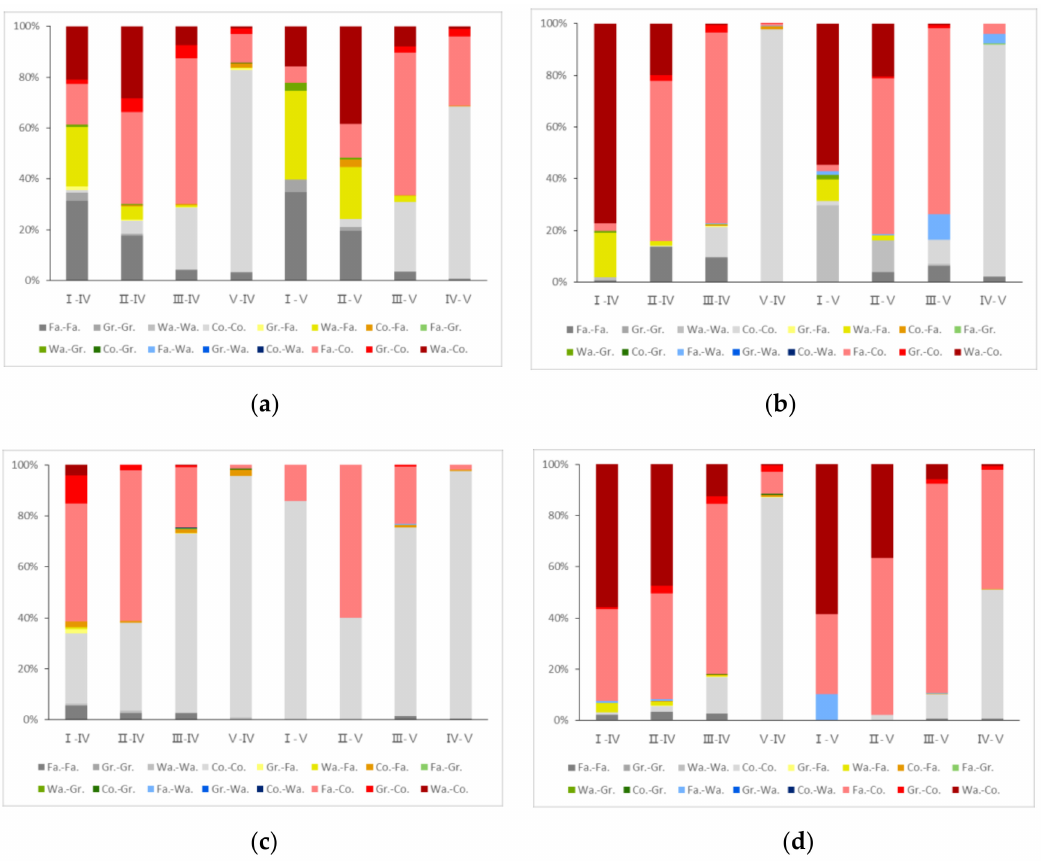
Figure 7. Area proportion of di ff erent LULC transitions for the inward transfer types of high temperature (level V) and sub-high temperature (level IV) during 1987–1996 ( a ), 1996–2007 ( b ), 2007–2016 ( c ) and 1987–2016 ( d ). In the legend, Fa., Gr., Wa. and Co. represent LULC types, namely farmland, greening land, water body and construction land, respectively. The symbol “-” indicates the transition process between di ff erent LULC types. For example, Gr.-Fa. represents the conversion from greening land to